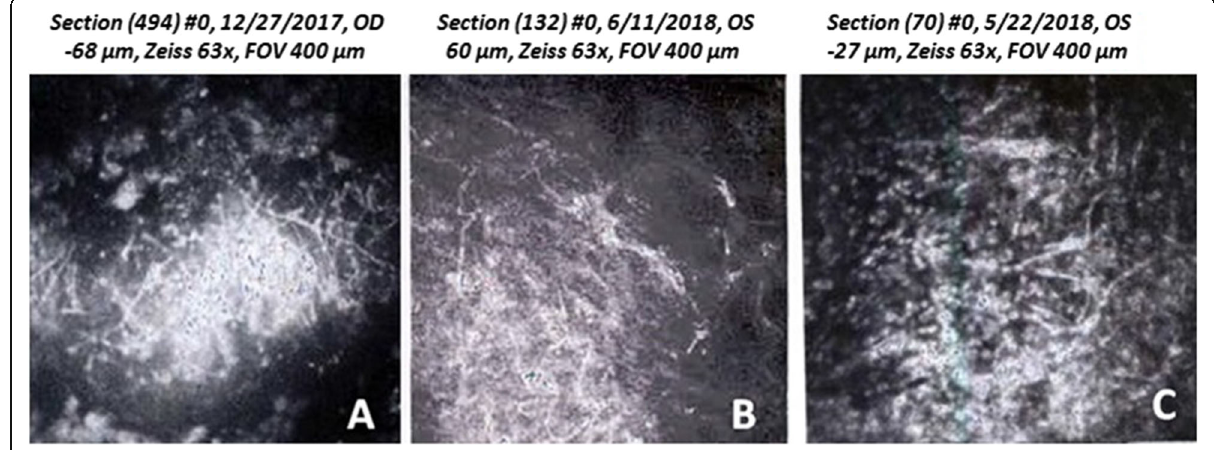
Fig. 2 In vivo confocal microscopy (IVCM) from patient 1 ( A ), patient 2 ( B ) and patient 3 ( C ) showing a mass of interlocking and diffuse, hyper- reflective and branching white lines indicating filamentus